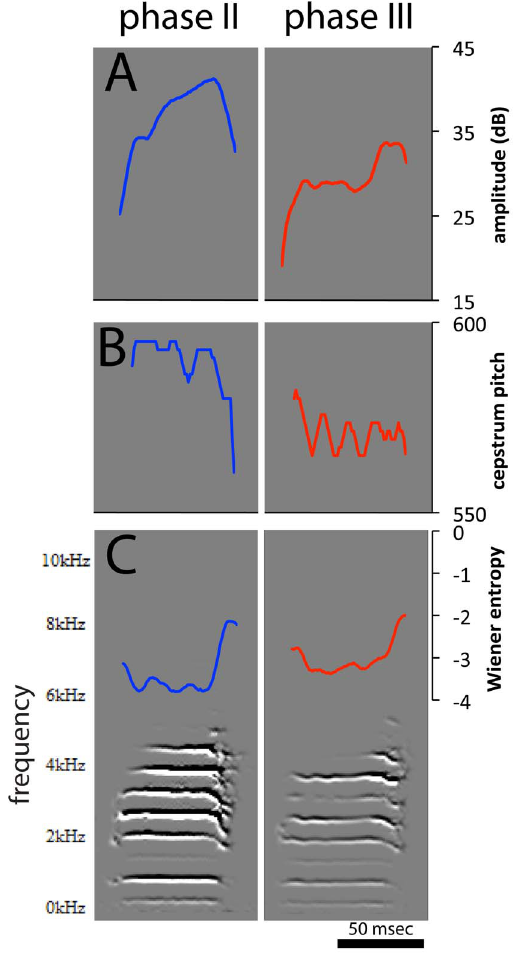
Fig. 9. Effects of alcohol drinking on a specific zebra finch song syllable. Shown are spectrograms of a representative syllable recorded in Phases II (no alcohol; left) and III (alcohol, mean BEC 5 53.4 mg/dl; right) overlaid with traces of (A) amplitude, (B) pitch, and (C) Wiener entropy (respective scales on the right). For this syllable there were significant decreases in mean amplitude and pitch, and an increase in entropy under alcohol; other acoustic features did not change (not